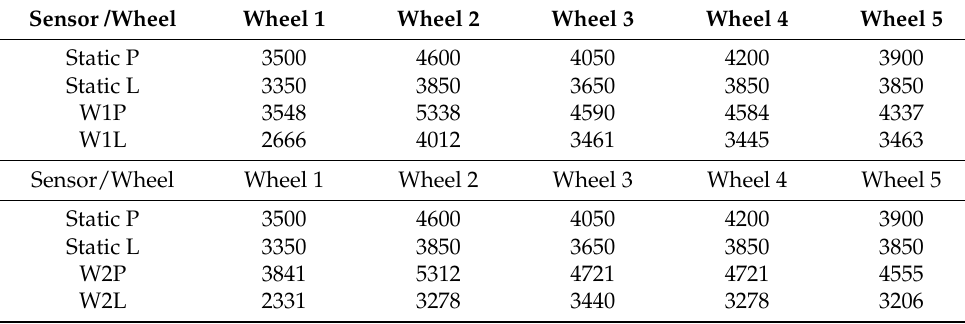
Table 14. Strain gauge sensor signal characteristics—wheel load (kg).